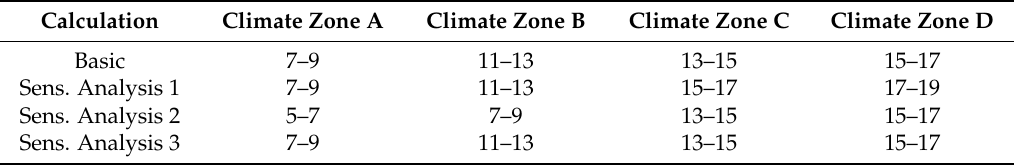
Table 10. Cost-optimal levels of insulation thickness (in cm) for the macroeconomic calculations 1